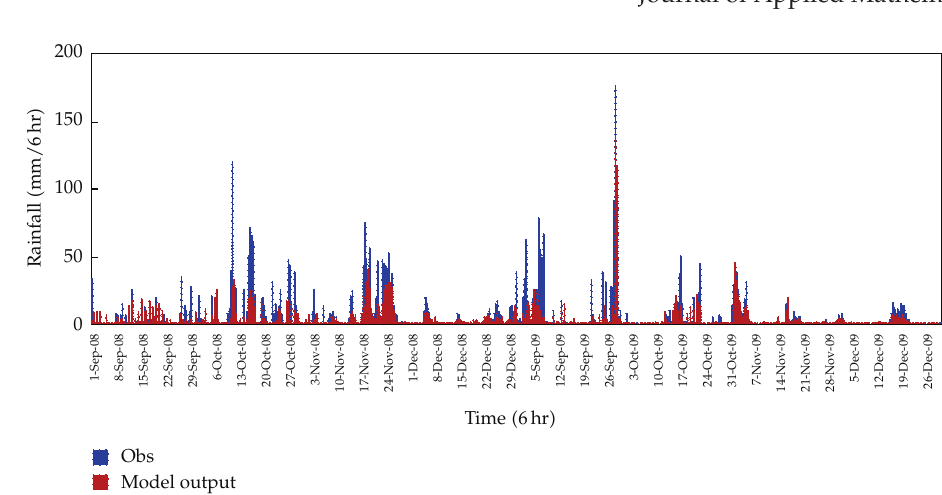
Figure 3: Time series of observed rainfall and those derived from the model outputs for wet seasons, 2008 and